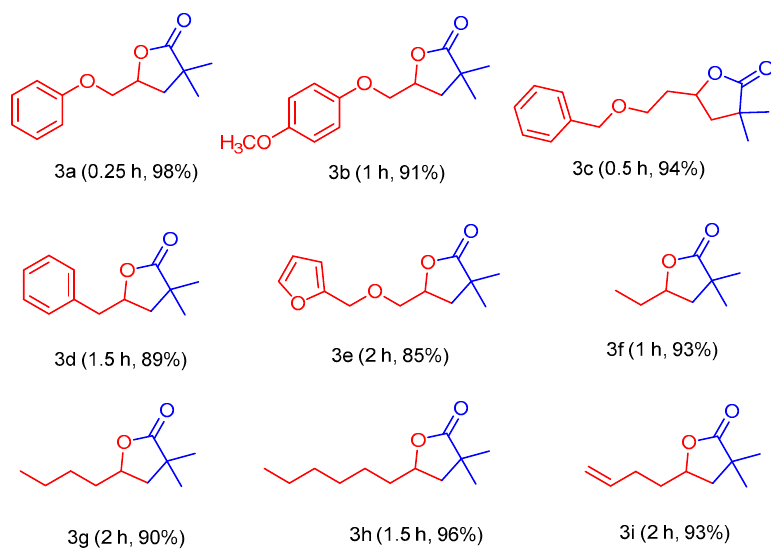
Figure 5. Prepared γ -lactones from the reaction of epoxides with KSA using task-specific [Dmim]F/ [Hbim]BF 4 ionic liquid mixture.